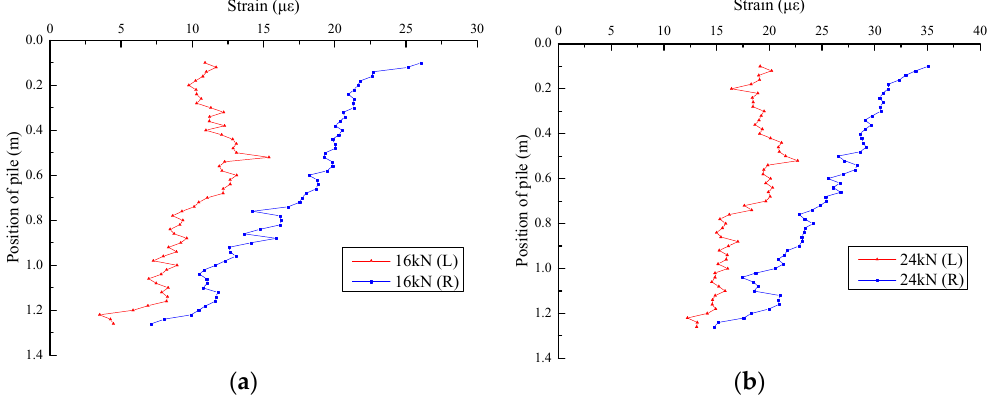
Figure 7. Strain curves of two sides of model pile. ( a ) Strain curves at 16 kN; ( b ) Strain curves at 24 kN.